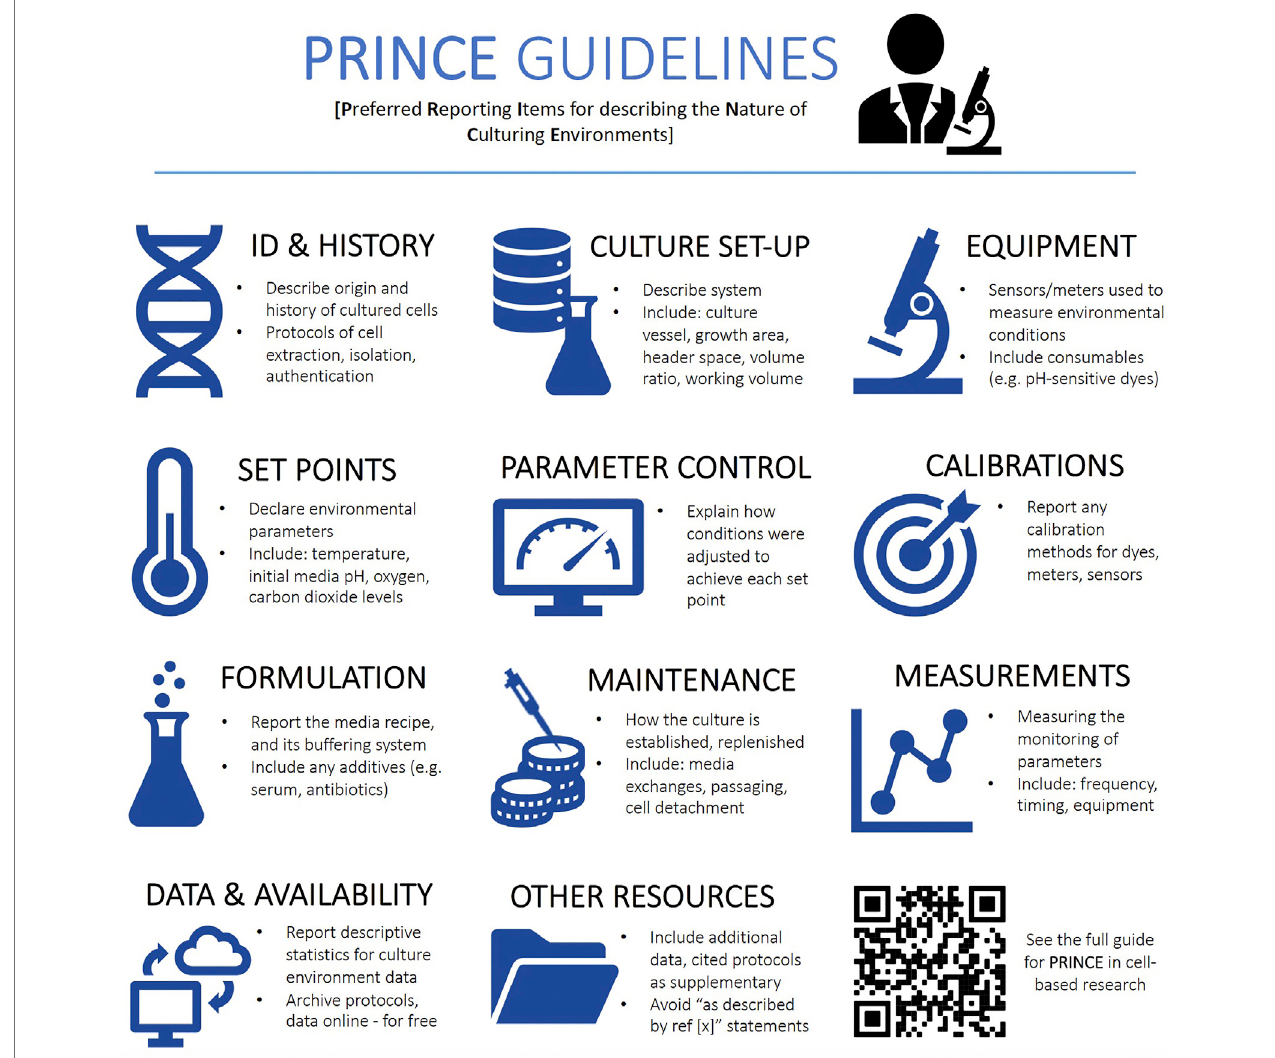
FIGURE1| Anoverview ofthePRINCE (Preferred Reporting Items for describing theNature ofCulturingEnvironments) guidelines.The QRprovides accessto the full PRINCE reporting checklist (also in Supplementary Extended Materials S1 ) containing an exhaustive list of reporting items.